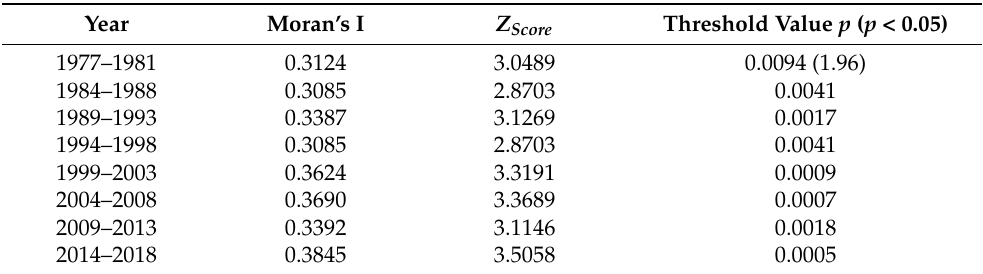
Table 4. Global Moran’s I value and statistical test for forest quality from the 2nd to 9th National Forestry Inventory